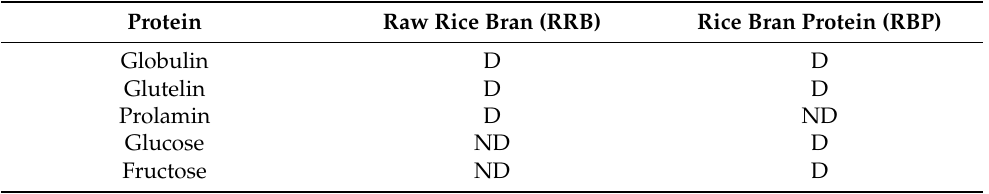
Table 2. Raw rice bran (RRB) and rice bran protein (RBP) in protein identification summary results. Protein Raw Rice Bran (RRB) Rice Bran Protein (RBP) Globulin D D Glutelin D D Prolamin D ND Glucose ND D Fructose ND D D = Detected, ND = Non-detected.